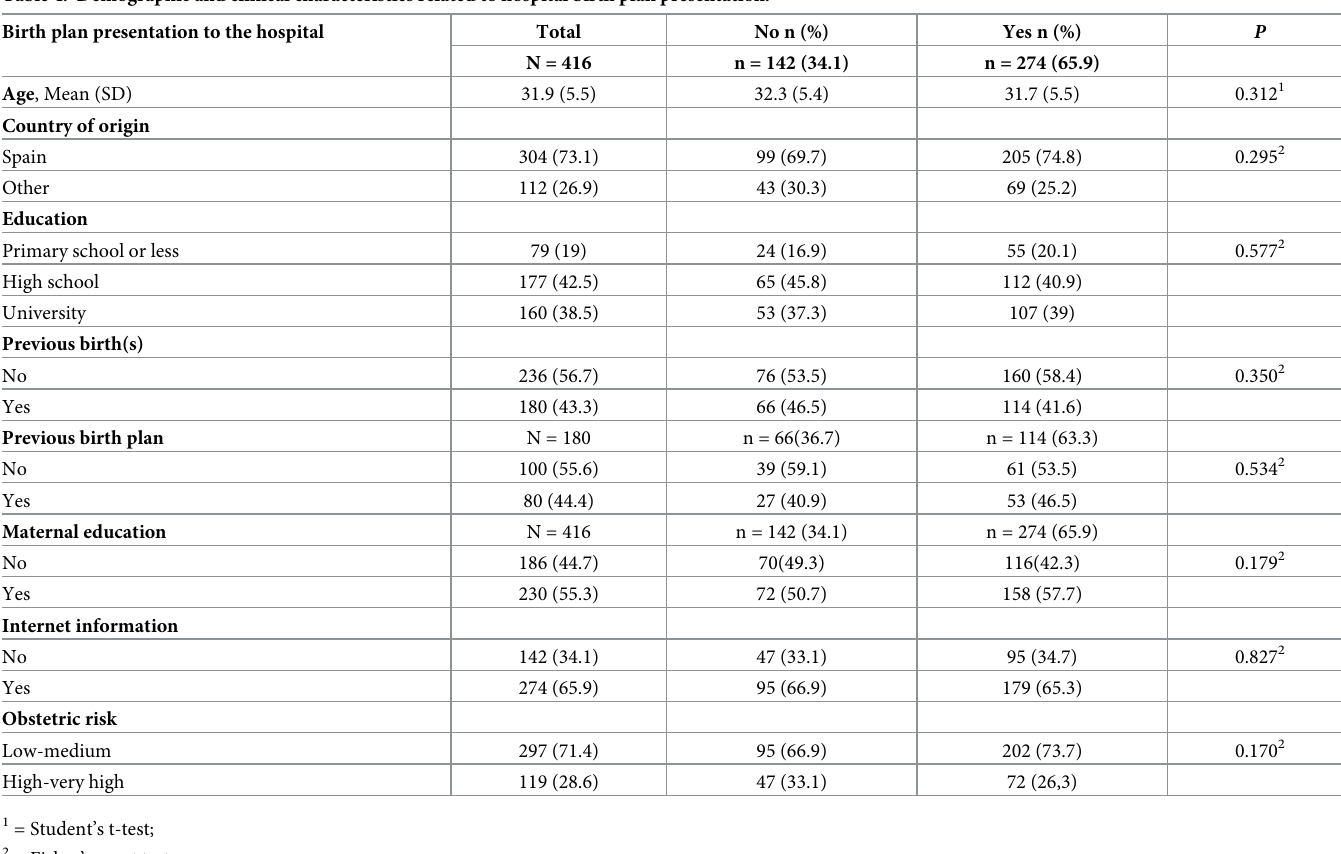
Table 4. Demographic and clinical characteristics related to hospital birth plan presentation.